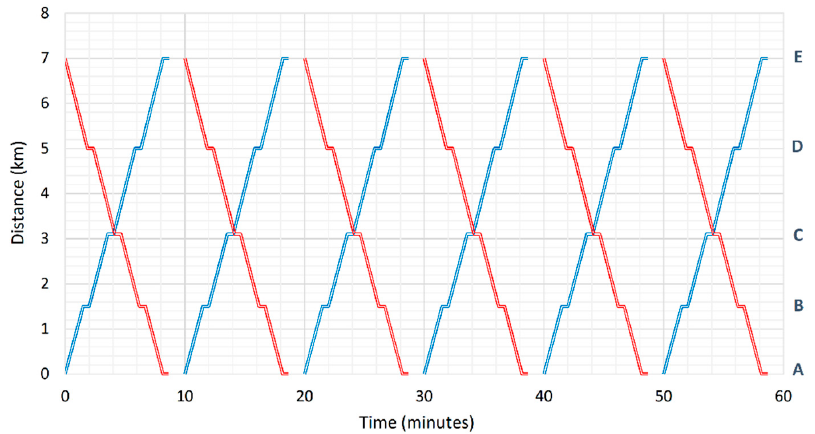
Figure A4. Simulation of 1 h tram operation between station A and B and return (10 min headway, 30 s dwell time).